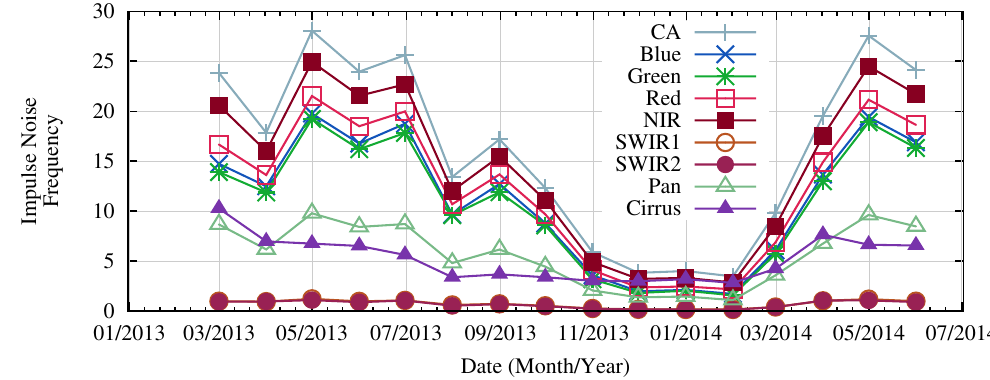
Figure 20. Per-band impulse noise occurrences for all standard shutter collects determined each month.